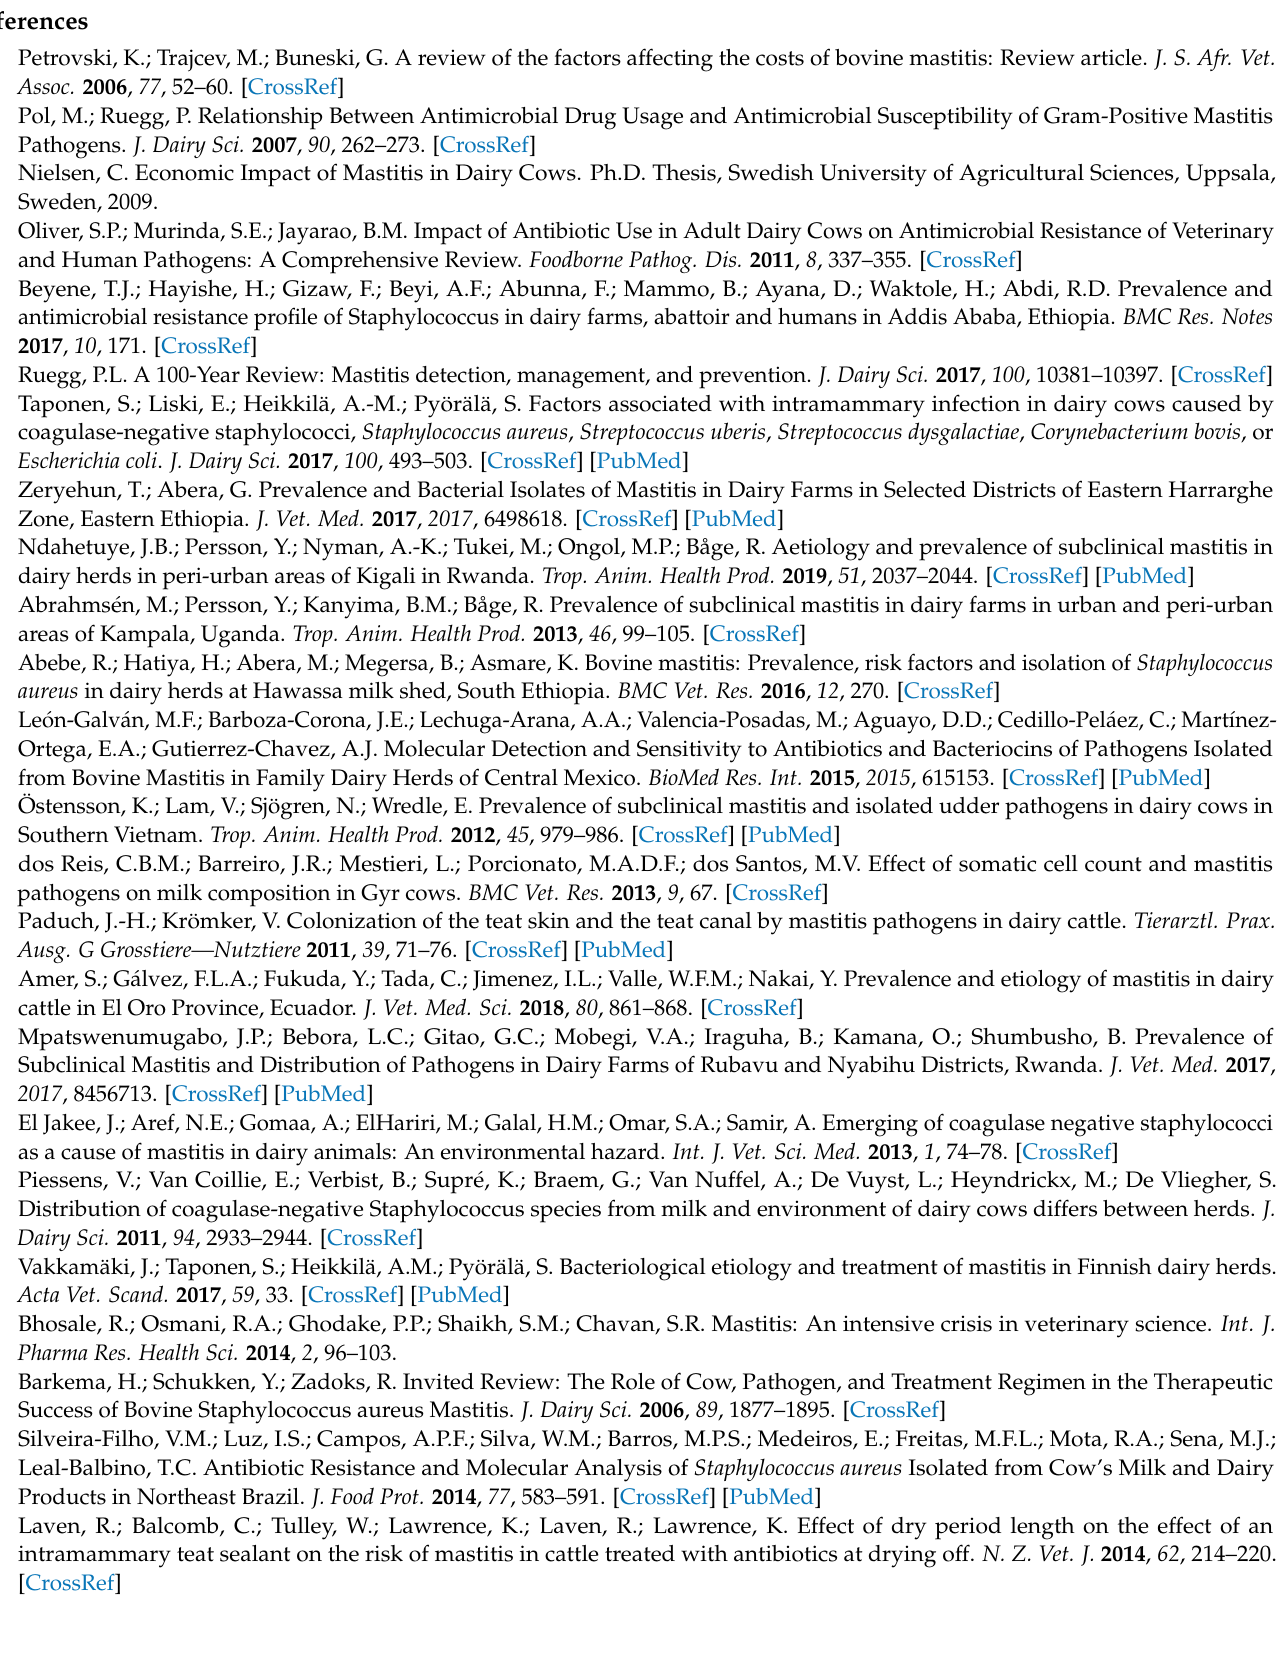
Statistical Analysis: Statistical analysis was performed using a Chi-square ( χ 2 ) test in SPP v 21.0 for Windows (SPPS Inc., Chicago, IL, USA) in order to evaluate the associations between the size of the farms and subclinical mastitis